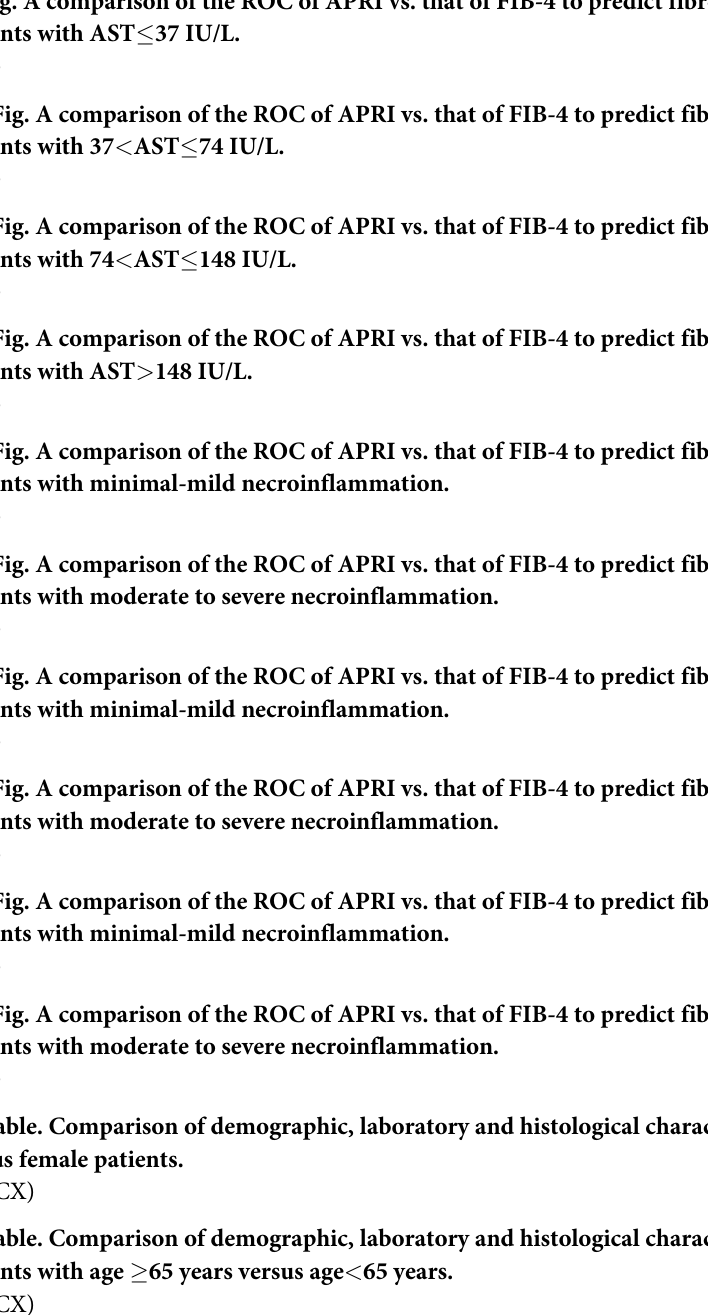
S7 Fig. A comparison of the ROC of APRI vs. that of FIB-4 to predict fibrosis (cid:21) 3 in patients with 74 < AST (cid:20) 148 IU/L. S8 Fig. A comparison of the ROC of APRI vs. that of FIB-4 to predict fibrosis (cid:21) 3 in patients with AST > 148 IU/L. S9 Fig. A comparison of the ROC of APRI vs. that of FIB-4 to predict fibrosis = 4 in patients with AST (cid:20) 37 IU/L. S10 Fig. A comparison of the ROC of APRI vs. that of FIB-4 to predict fibrosis = 4 in patients with 37 < AST (cid:20) 74 IU/L. S11 Fig. A comparison of the ROC of APRI vs. that of FIB-4 to predict fibrosis = 4 in patients with 74 < AST (cid:20) 148 IU/L. S12 Fig. A comparison of the ROC of APRI vs. that of FIB-4 to predict fibrosis = 4 in patients with AST > 148 IU/L. S13 Fig. A comparison of the ROC of APRI vs. that of FIB-4 to predict fibrosis (cid:21) 2 in patients with minimal-mild necroinflammation. S14 Fig. A comparison of the ROC of APRI vs. that of FIB-4 to predict fibrosis (cid:21) 2 in patients with moderate to severe necroinflammation. S15 Fig. A comparison of the ROC of APRI vs. that of FIB-4 to predict fibrosis (cid:21) 3 in patients with minimal-mild necroinflammation. S16 Fig. A comparison of the ROC of APRI vs. that of FIB-4 to predict fibrosis (cid:21) 3 in patients with moderate to severe necroinflammation. S17 Fig. A comparison of the ROC of APRI vs. that of FIB-4 to predict fibrosis = 4 in patients with minimal-mild necroinflammation. S18 Fig. A comparison of the ROC of APRI vs. that of FIB-4 to predict fibrosis = 4 in patients with moderate to severe necroinflammation. S1 Table. Comparison of demographic, laboratory and histological characteristics in male versus female patients. S2 Table. Comparison of demographic, laboratory and histological characteristics in patients with age (cid:21) 65 years versus age < 65